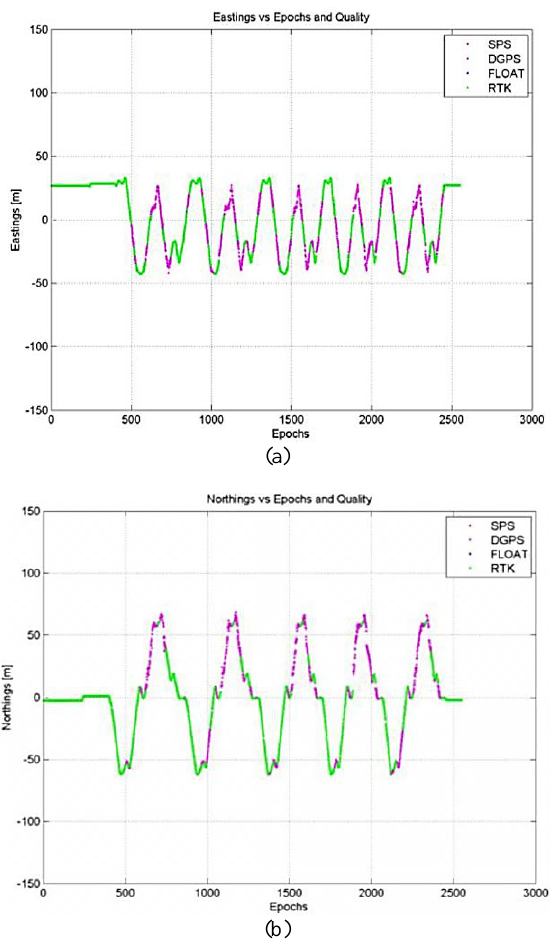
Figure 10. Mobile Kinematic Results: (a) GS10 Easting Time Series; (b) GS10 Northing Time Series.